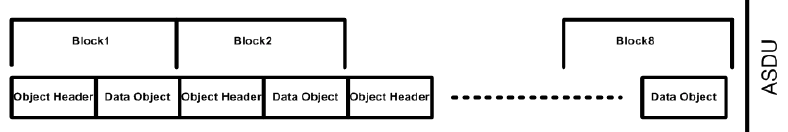
Figure 5. New logical fixing of ASDU.